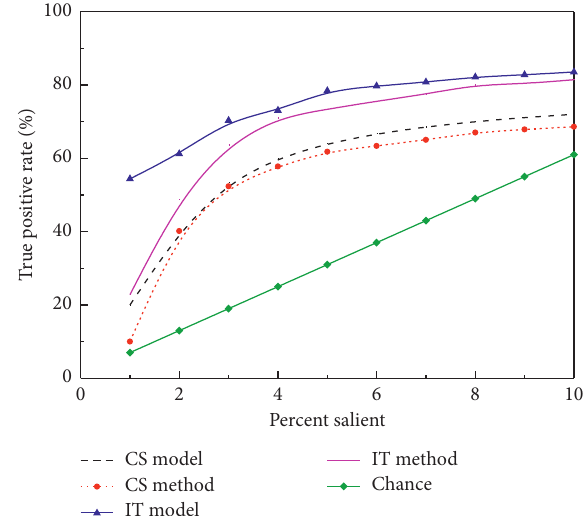
Figure 8: The ROC curves of CS and IT models on standard contour and rough contour,